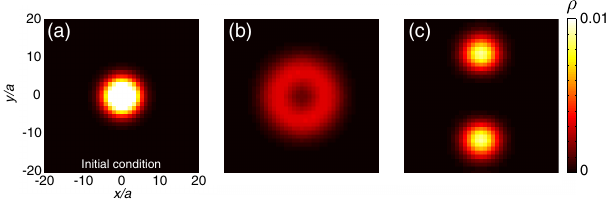
FIG. 5. The dynamics associated with the driving sequence (55) on a lattice. (a) The Gaussian wave packet is initially prepared around x ð 0 Þ ¼ 0 and momentum k ¼ 0 , so as to probe the Dirac dispersion relation of the effective Rashba Hamiltonian in Eq. (61) ( Δ k ≪ m (cid:4) λ ). (b),(c) Shown is the time-evolved particle R density ρ ð x; y Þ in the x - y plane at time t ¼ 7 . 3 ð 1 =J Þ , for κ ¼ 40 J=a , and T ¼ 7 π = 100 ð 1 =J Þ , i.e., λ ≈ ð π = 3 Þ Ja . (b) R The driving follows the sequence (55) starting with the pulse ˆ A . (c) Same but starting with the pulse − ˆ B , i.e., changing the þ initial phase of the